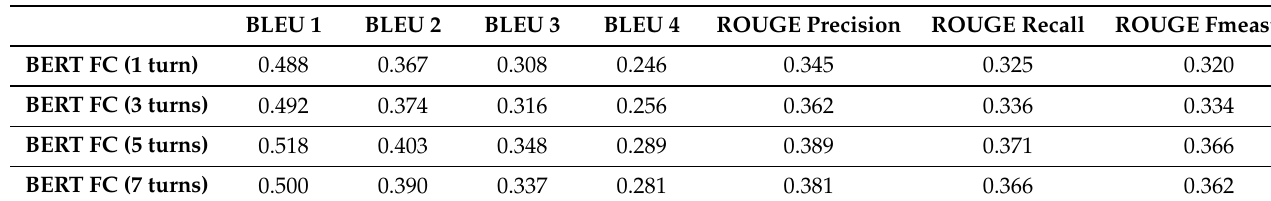
Figure 5. Chart showing the performance of experiments measured by BLEU score ( a ) and ROUGE score ( b ). Table 3. Model performance using different lengths of simulated conversation.